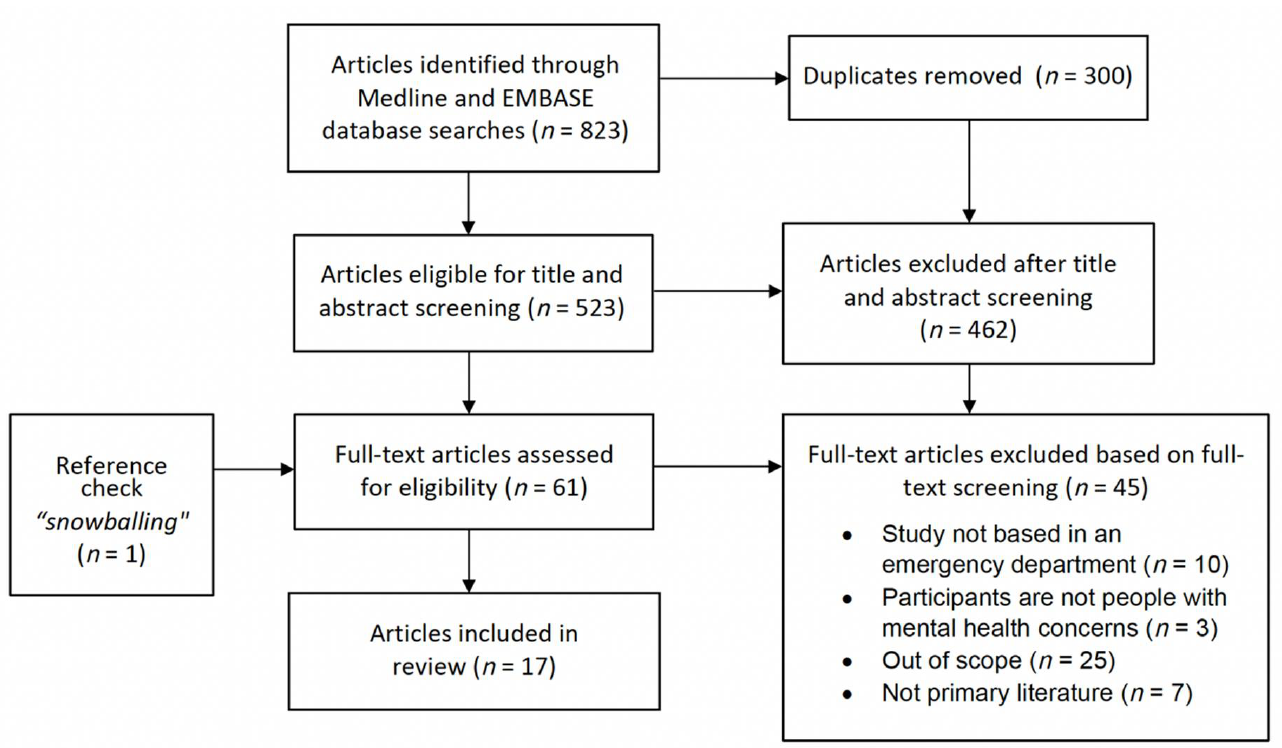
Figure 1. PRISMA diagram of the study review process.